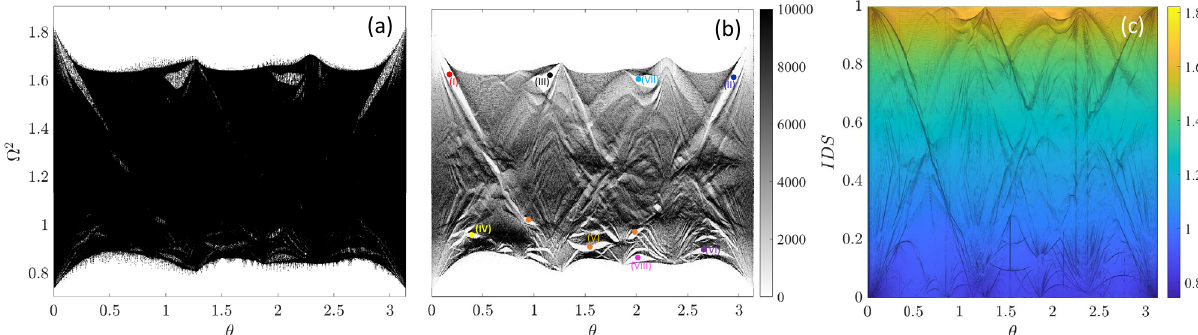
ffiffiffi ffiffi ½p p ; a = 7 4 (cid:3) 2 ; a 2 ¼ 1. a Eigenfrequencies ( Ω 2 ) of 100 × 100 lattice calculated with periodic 1 ¼ 1